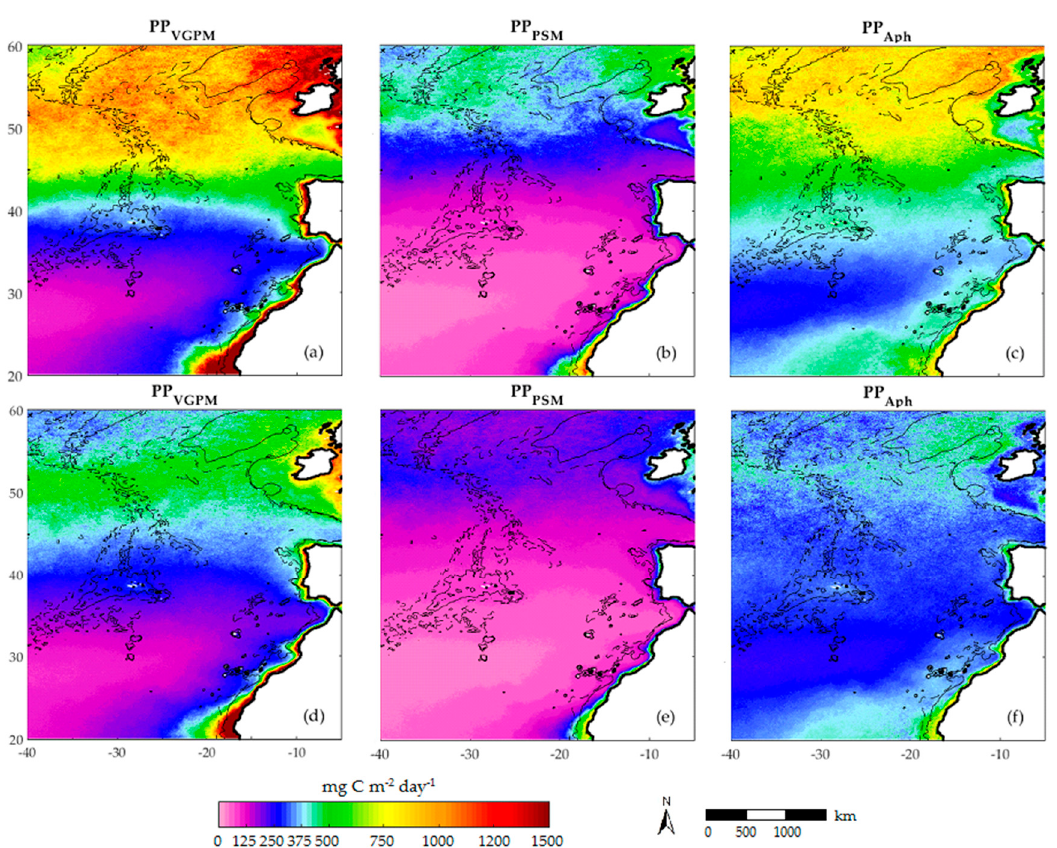
Figure 6. Spatial distribution of satellite PP eu [mg C m − 2 day − 1 ] using OC-CCI climatology for 1998–2011 for; ( a ) PP VGPM in summer (June–August), ( b ) PP PSM in summer, ( c ) PP Aph in summer, ( d ) PP VGPM in autumn (September–November), ( e ) PP PSM in autumn, and ( f ) PP Aph in autumn.